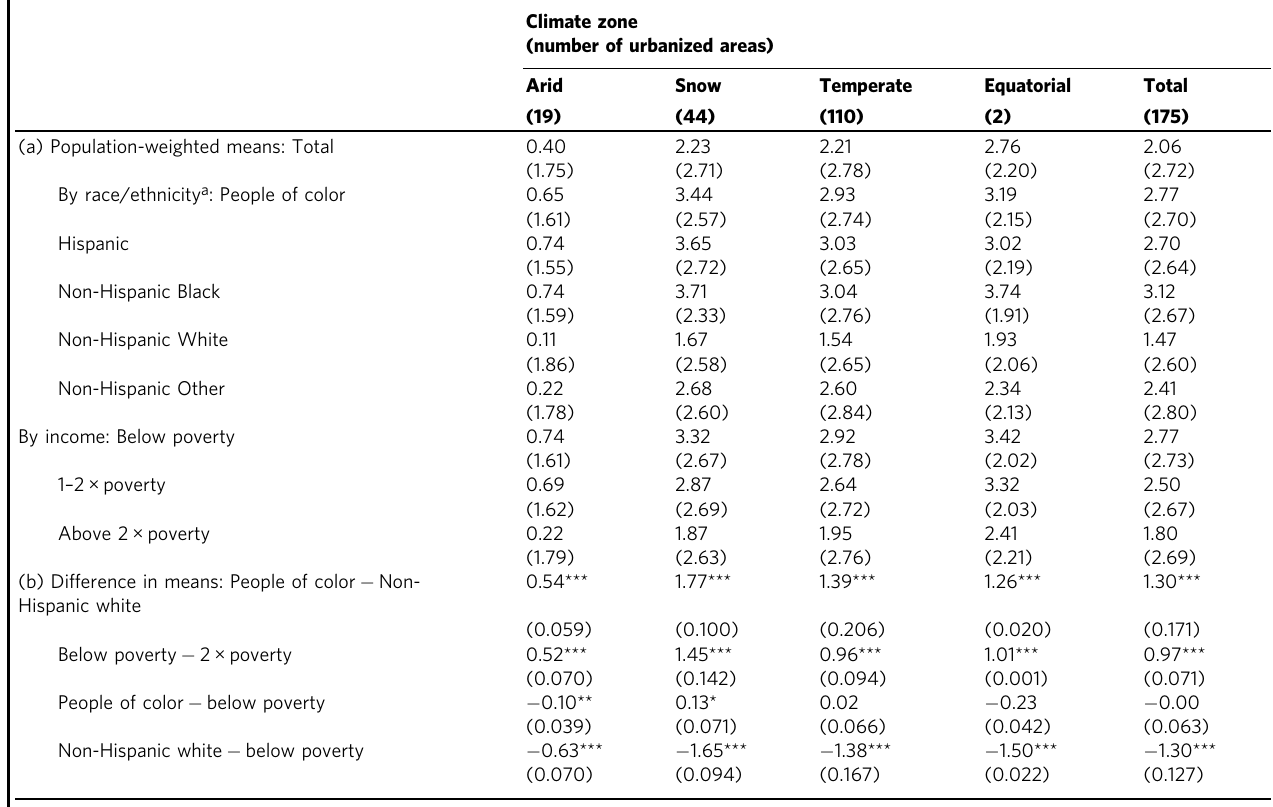
Table 1 Mean summer daytime surface urban heat island intensity (SUHI) by climate zone and sociodemographic group. Climate zone (number of urbanized areas) Arid Snow Temperate